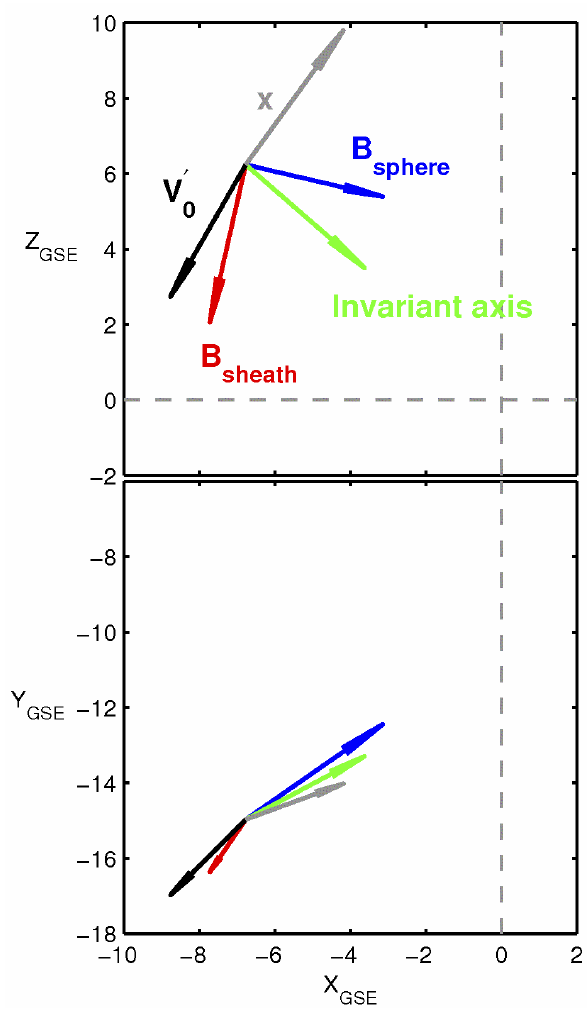
Fig. 4. Schematic of magnetic fields and invariant axis. The fig- ure shows a projection onto the GSE xz-plane (upper panel) and xy-plane (lower panel) of the magnetospheric and magnetosheath fields and the invariant axis (the X-line and its motion along the =[ − 59.8, − 59.9, − 105.2]km/s) at magnetopause with velocity V 0 0 the observation site (the point of origin of the vectors) on the dawn- side northern magnetopause. Also shown is the x-axis used in the